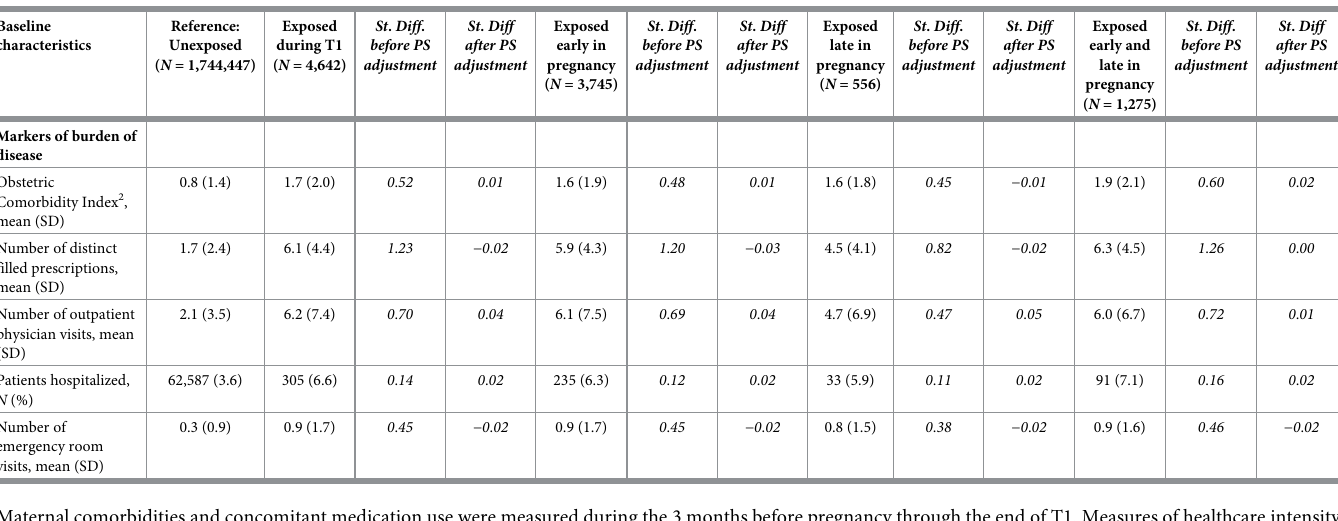
restricted to subsets of the gabapentin-exposed population, particularly for women with late exposure only. Of note, the risk of cardiac malformations in pregnancies exposed to gabapen- tin during T1 was increased when we redefined the exposure based on � 2 filled prescriptions